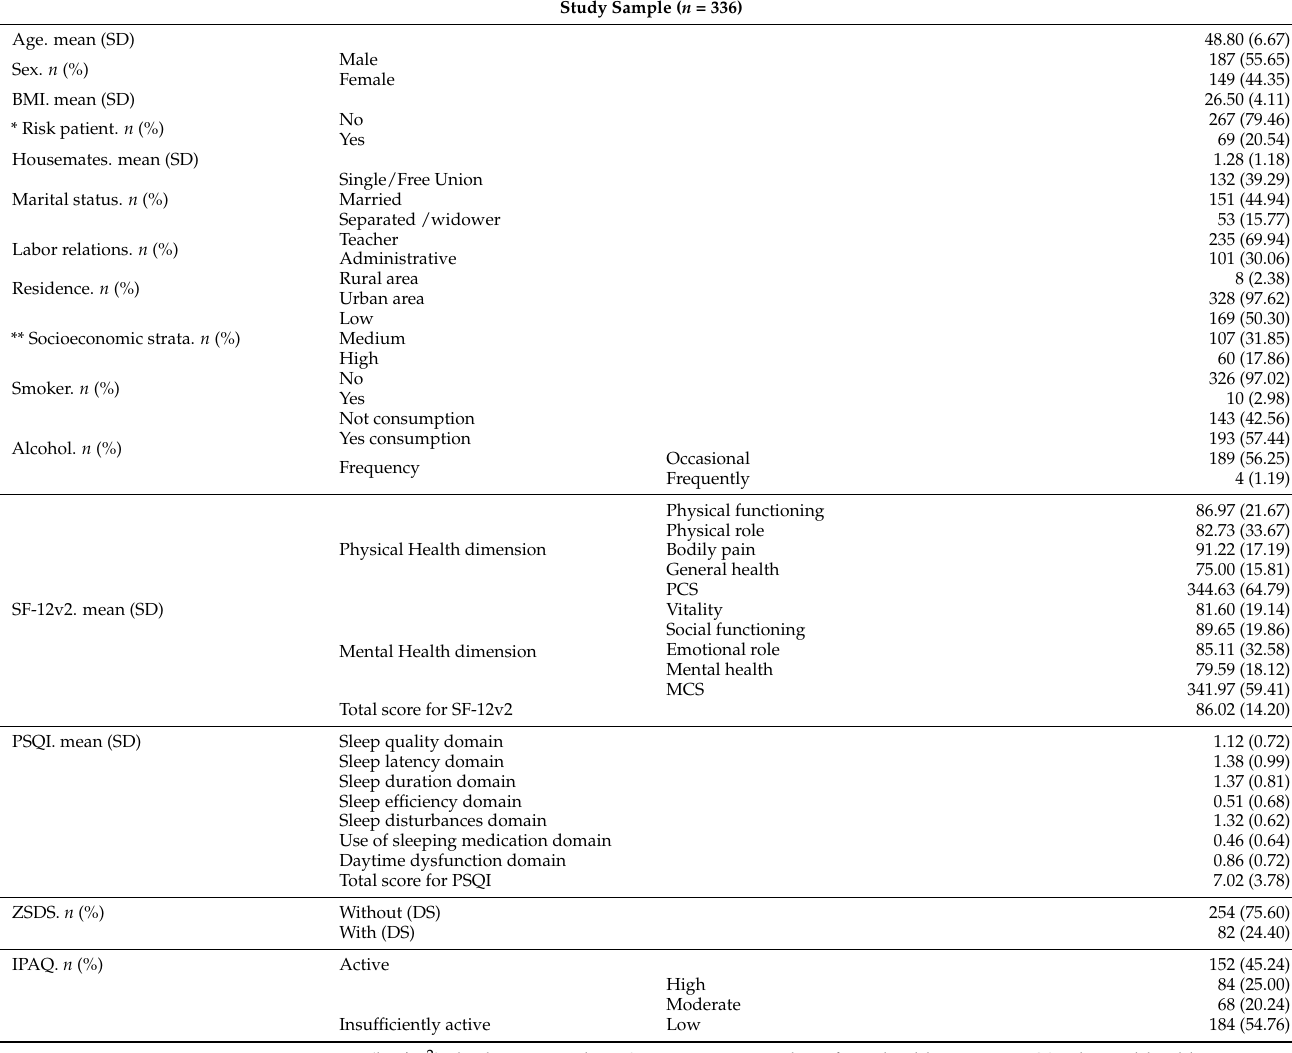
Table 1. Descriptive data of the